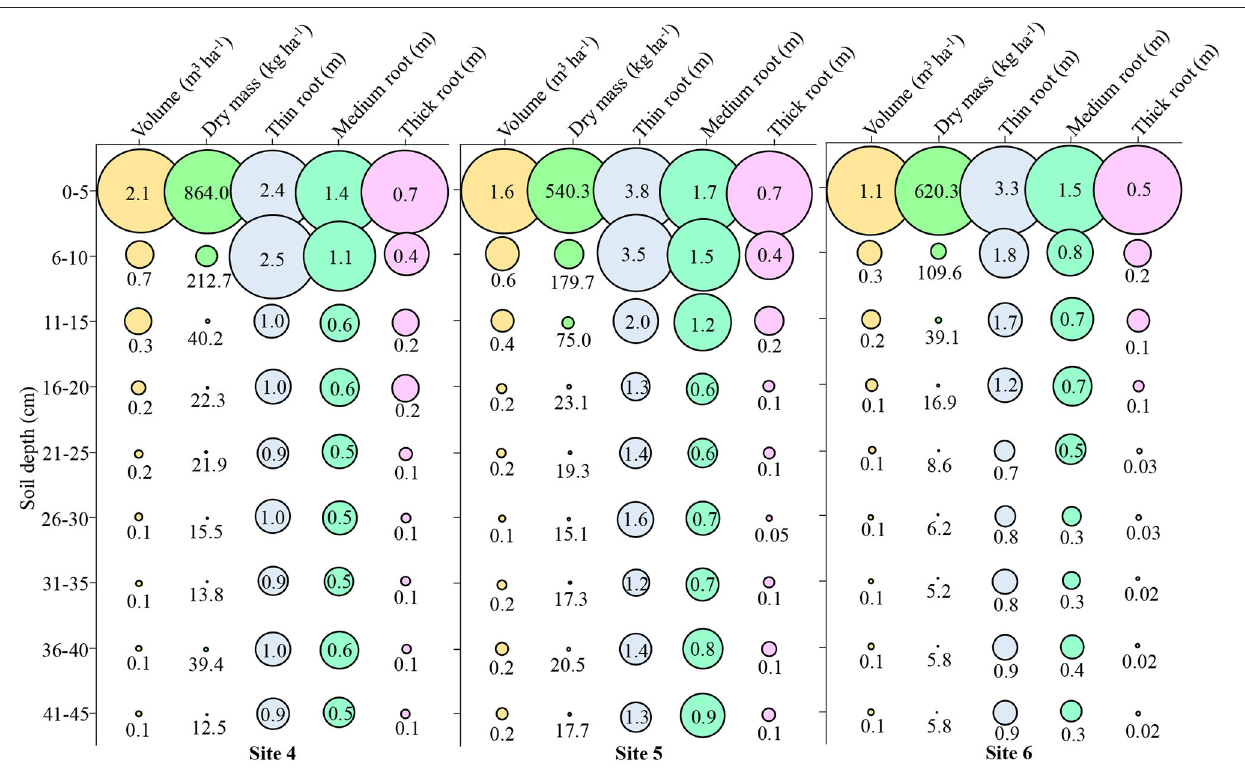
FIGURE 9 | Attributes of root growth in soybean in Site 4, Site 5, and Site 6 at different soil depths. Fine roots ( < 0.5mm); Medium roots (0.5–2mm); Thick roots ( >